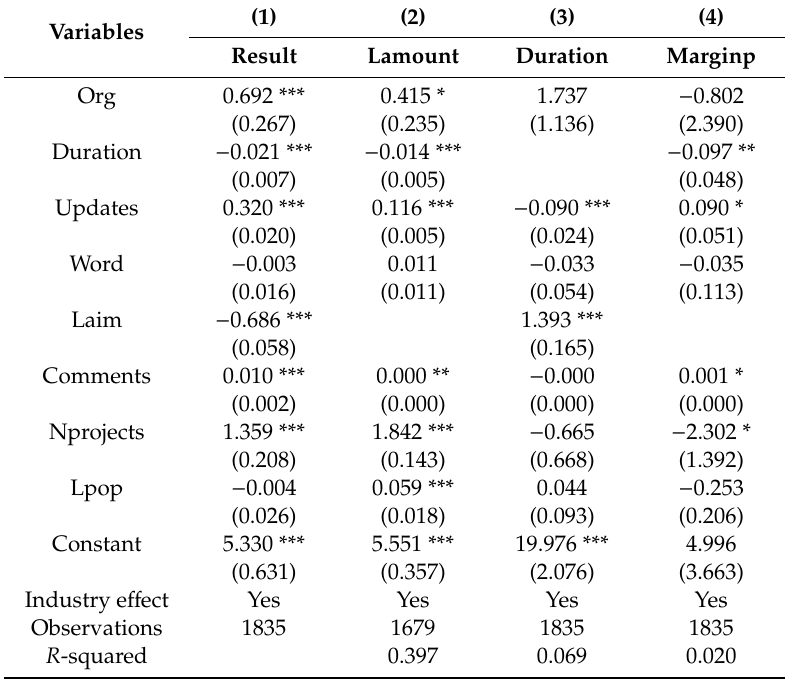
Table 14. Organization results. This table reports the relationship between geographical e ff ects and the success of a project. We control for di ff erent variables. Table 3 defines all the